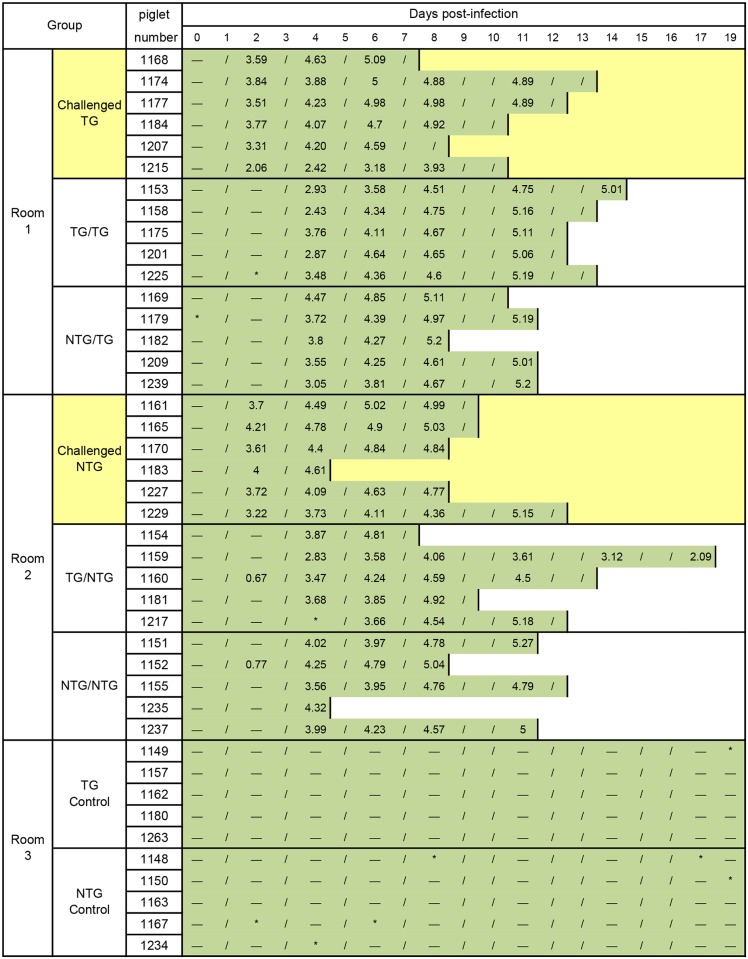
Mortality and viral load data for the challenge and in-contact groups in the study.Two groups of six TG pigs or six NTG pigs were “challenged” groups that were infected with JXA1 on day 0 and then housed with five TG and five NTG “in-contact” pigs, respectively. The length of the green bar indicates survival times. The numbers for each day represent the estimated viral titer in blood samples, which is expressed as log10 TCID50/100 μL. “-” indicates that no virus was detected, “*” indicates that blood sample was damaged, and “/” indicates that the blood sample was not collected.